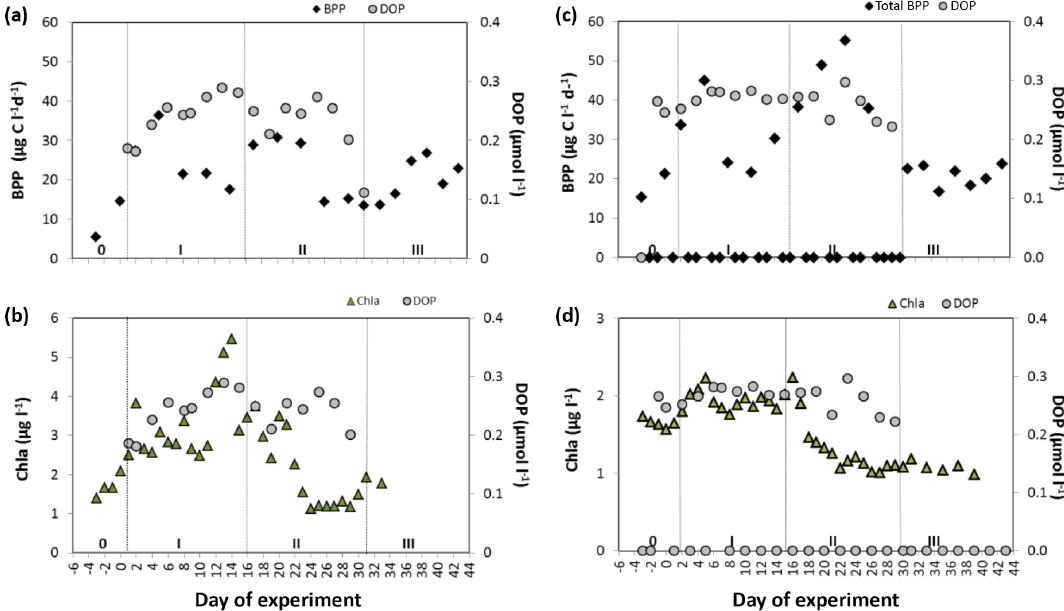
Figure 8. Development of DOP in relation to bacterial production (BPP) and phytoplankton biomass (Chl a) in the fjord (a, b) and in the mesocosms (c, d) . For mesocosms, mean values averaged over all treatments are given.